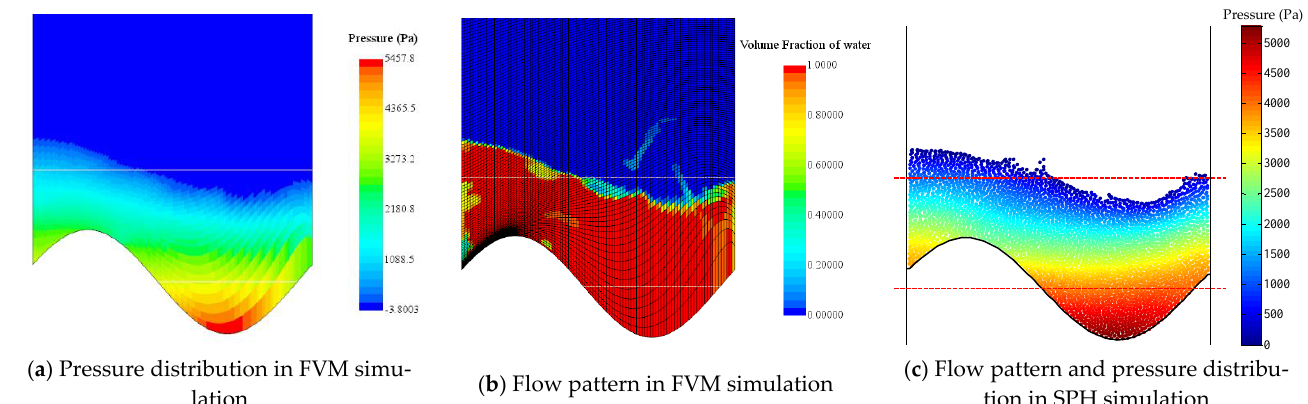
Figure 18. Comparisons of the flow pattern and pressure distribution at 18.0 s: ( a ) Pressure distribution in FVM simulation; ( b ) Flow pattern in FVM simulation; ( c ) Flow pattern and pressure distribution in SPH simulation.